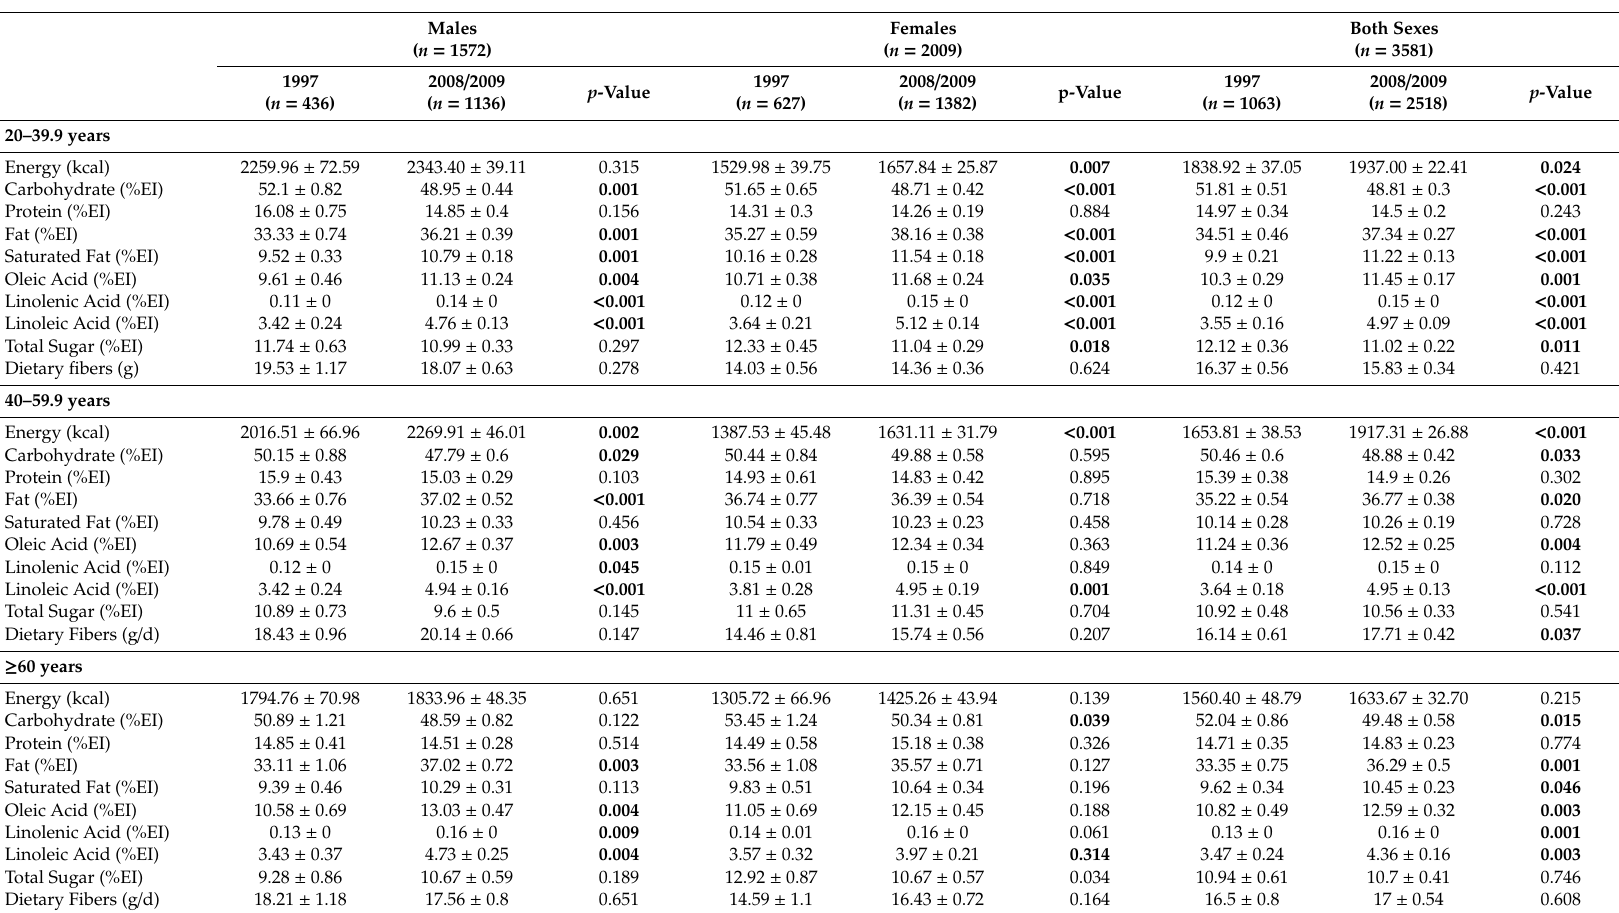
Table 3. Mean daily total energy (kcal) and macronutrient intake (%EI) (by sex and age) and their comparison between 1997 and 2008 / 2009, in the study population ( n = 3581), aged ≥ 20 years,